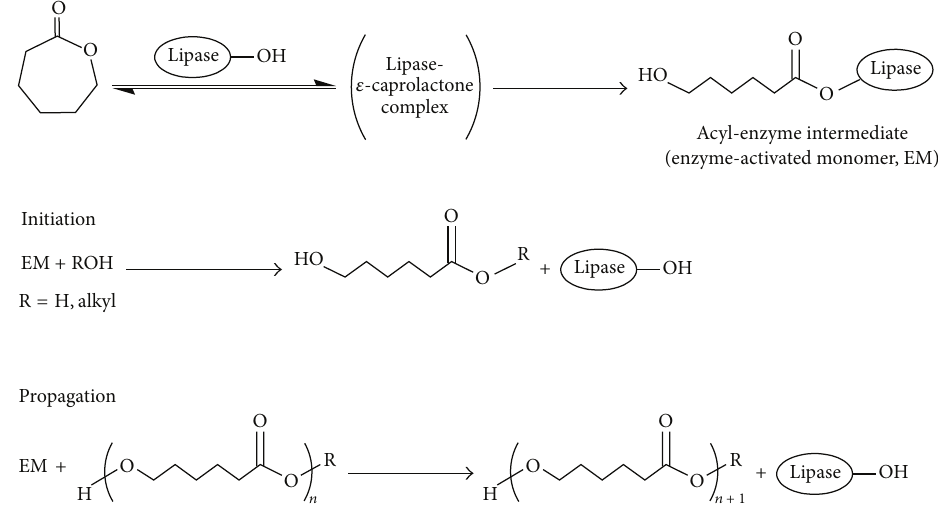
Figure 1: Synthesis mechanism of lipase-catalyzed eROP of CL